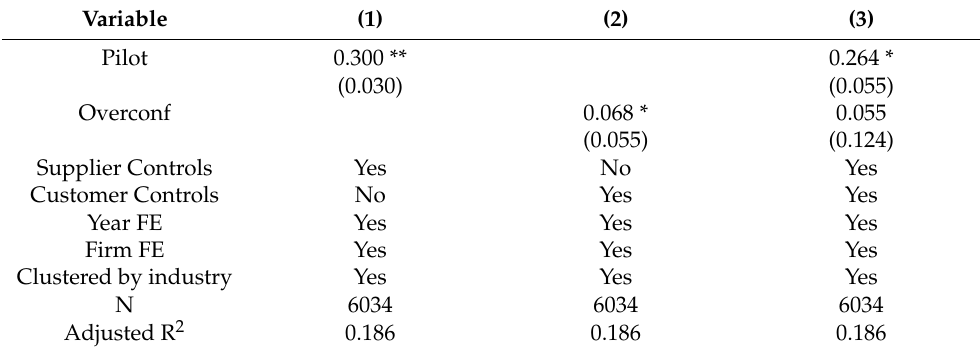
Table 6. Robustness tests: OLS regressions.